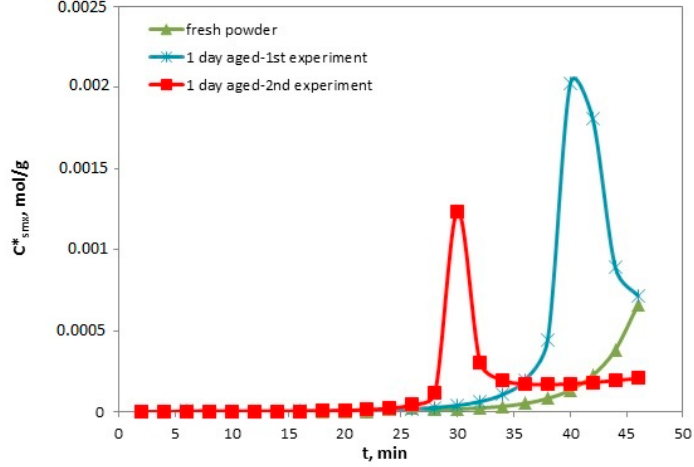
Figure 11. The aging effect on the local monolayer capacity concerning the system H 2 /Ni: fresh catalyst, 1 day aged catalyst (first experiment), 1 day aged (second experiment).